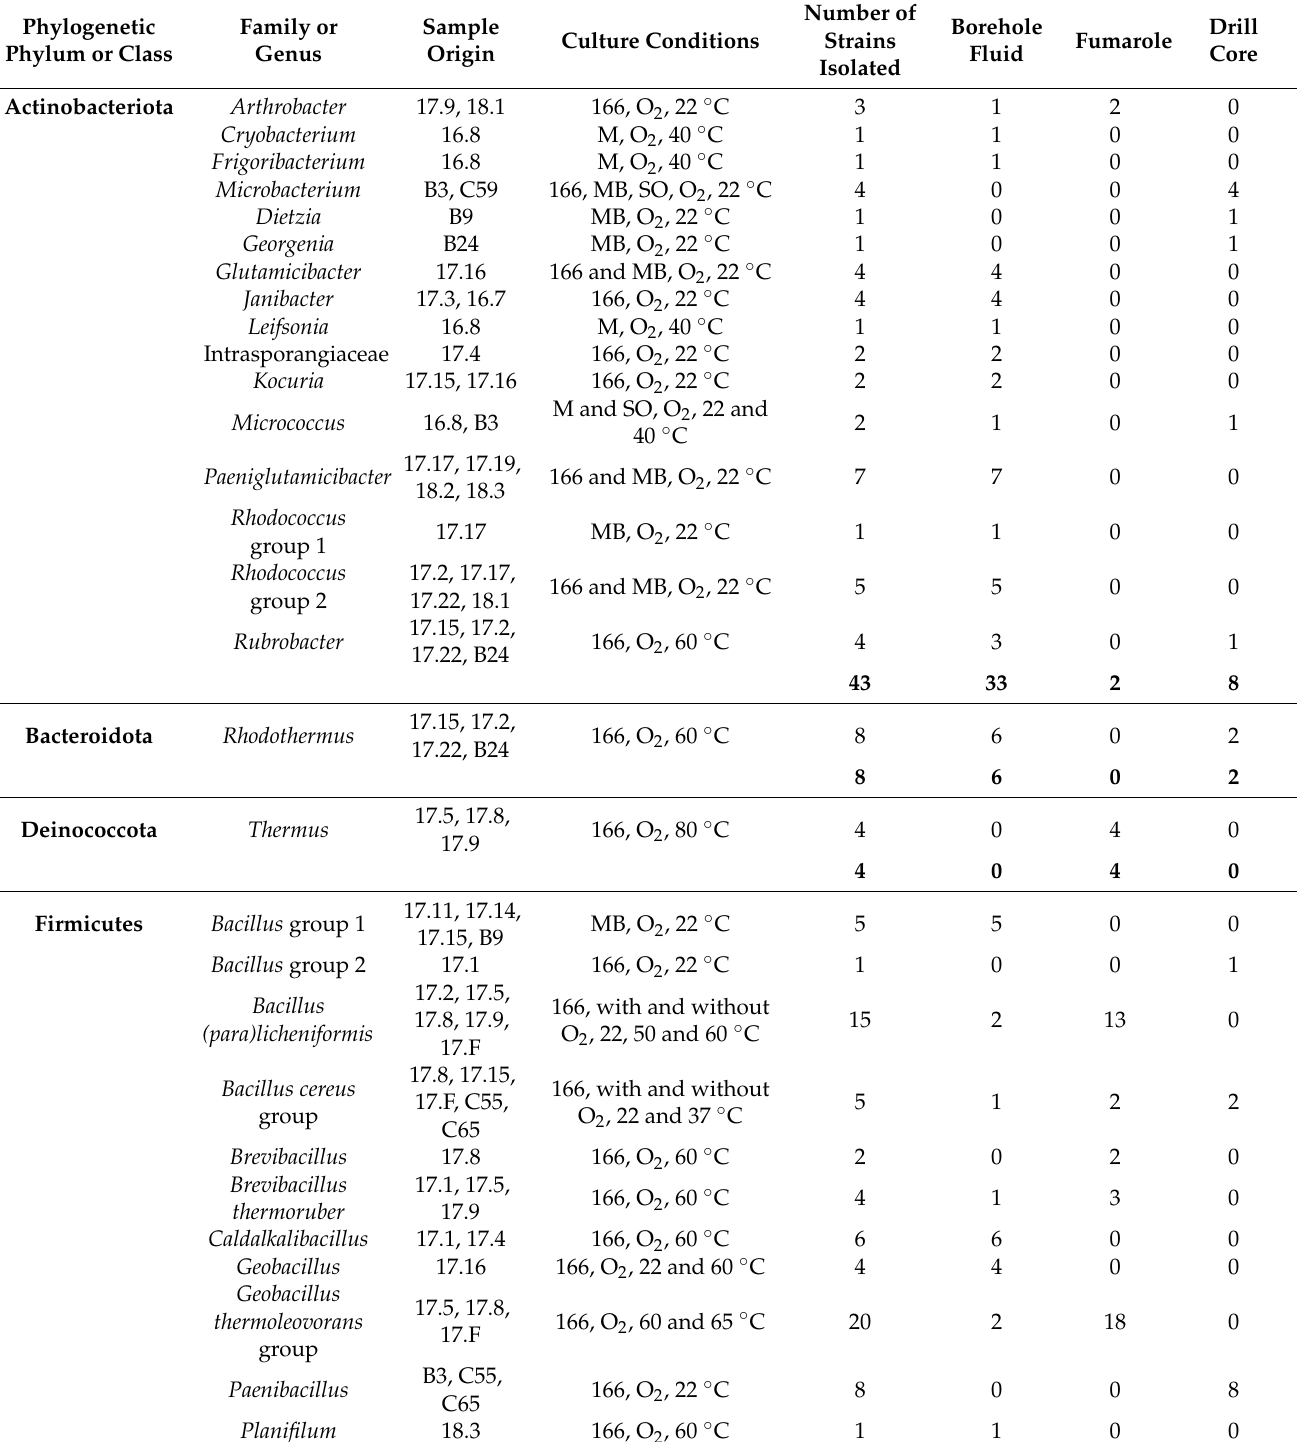
Table 2. Phylogenetic affiliations of the isolates based on a comparative analysis of their 16S rRNA gene sequences with the SILVA